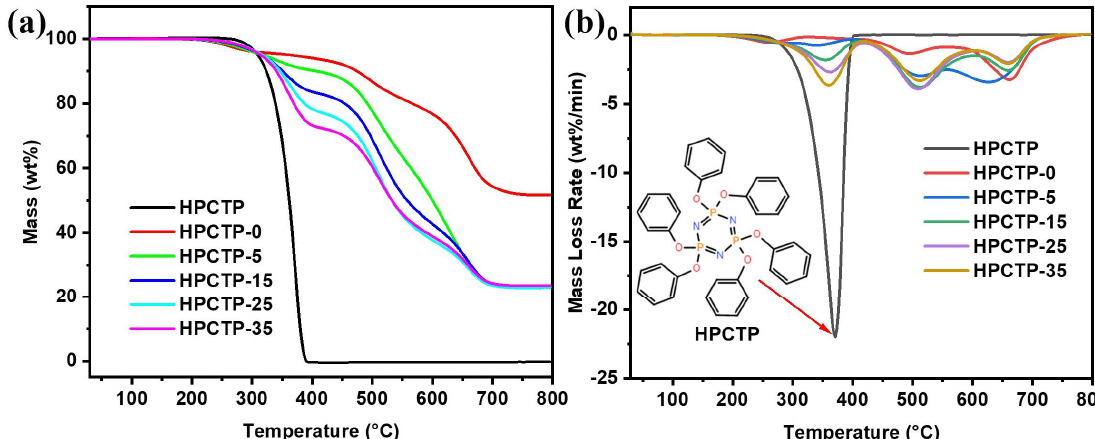
Figure 2. ( a ) TG and ( b ) DTG curves of HPTCP and HPCTP-containing EMVSR composites.